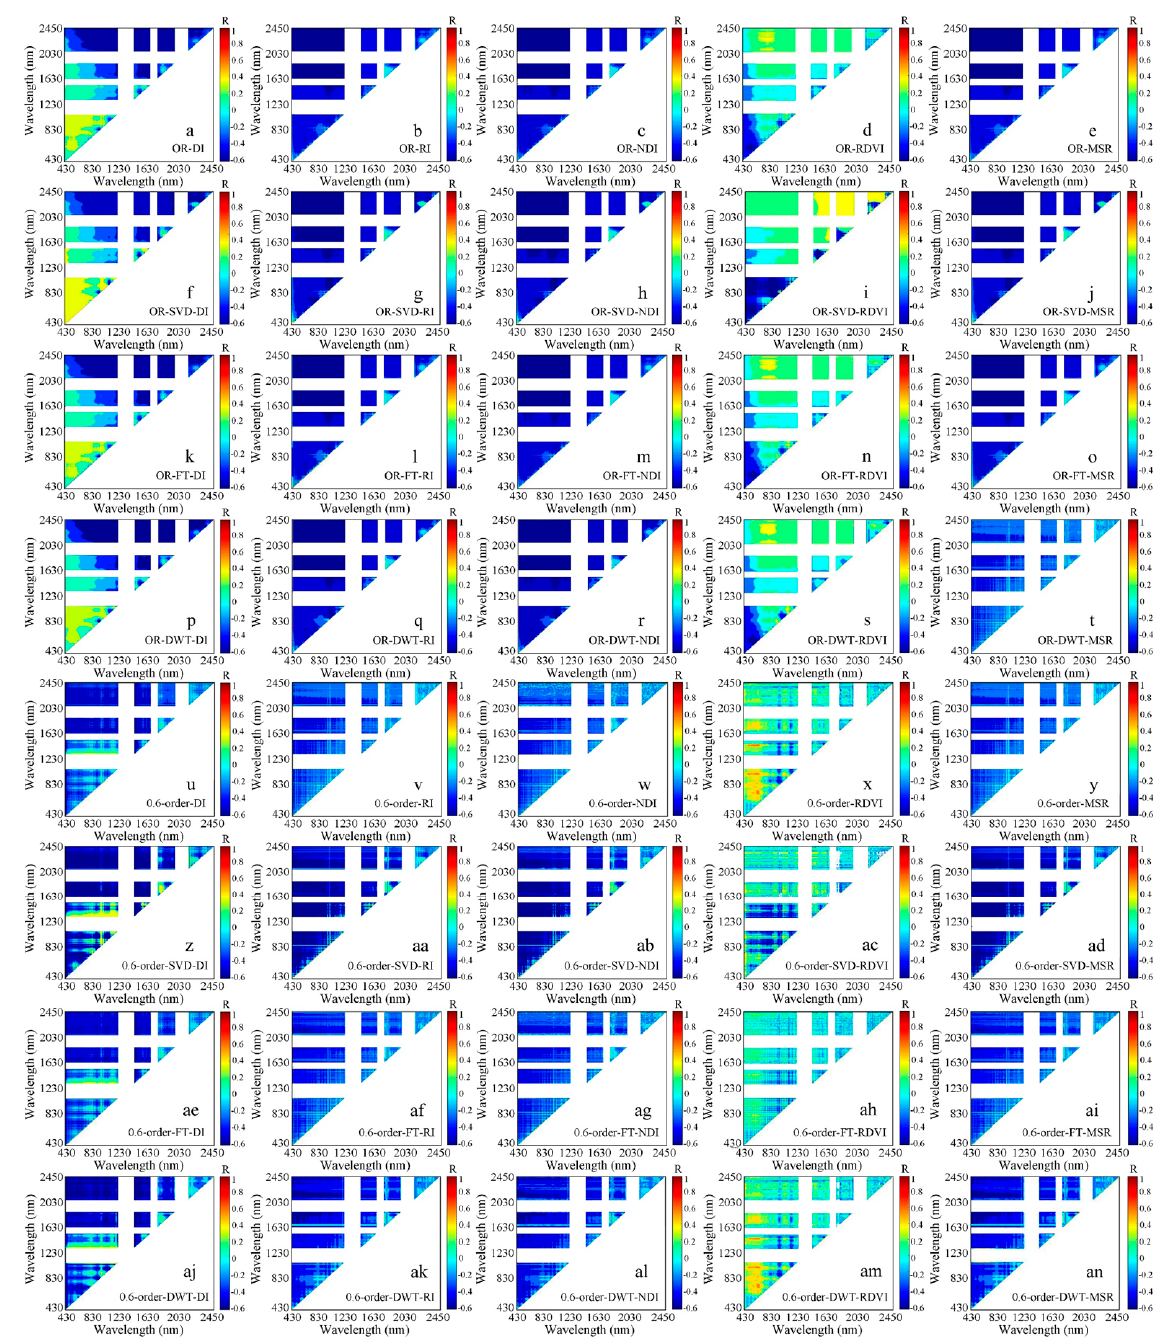
Figure 4. Established optimal spectral indexes under different denoising methods. Note: OR-DI represents the difference index of the OR, OR-SVD-DI represents the difference index of the reflectance after SVD processing, 0.6-order-SVD-DI represents the difference index of the 0.6-order reflectance after SVD, etc.